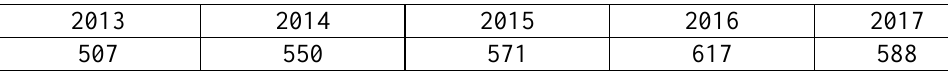
Table 3: Number of